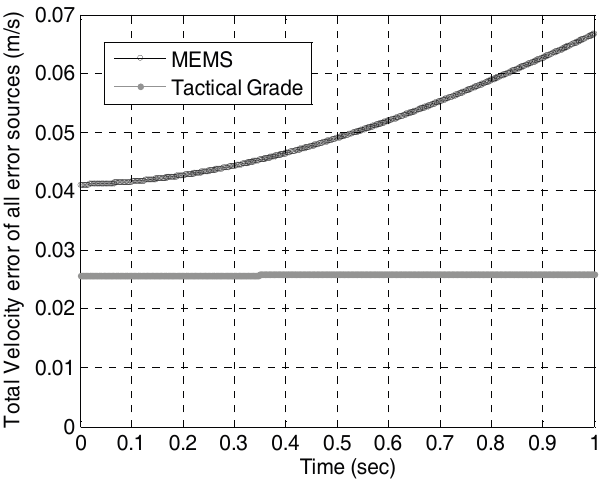
Figure 5. The total maneuver-independent velocity errors caused by all error sources.